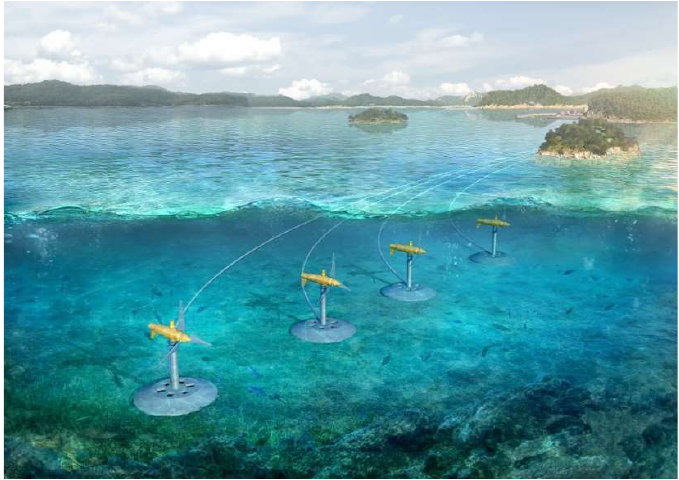
Figure 12. Open sea test site for TEC.